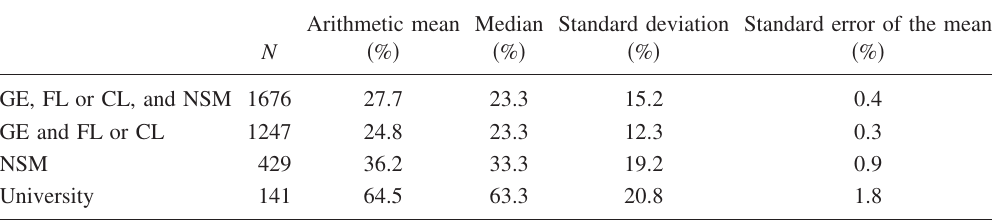
TABLE I. Statistical information for all groups of students (cid:1) NSM stands for gymnasiums which specialize in natural sciences and mathematics, GE for gymnasiums of general education type, and FL or CL for gymnasiums which specialize in foreign or classical languages (cid:2) .